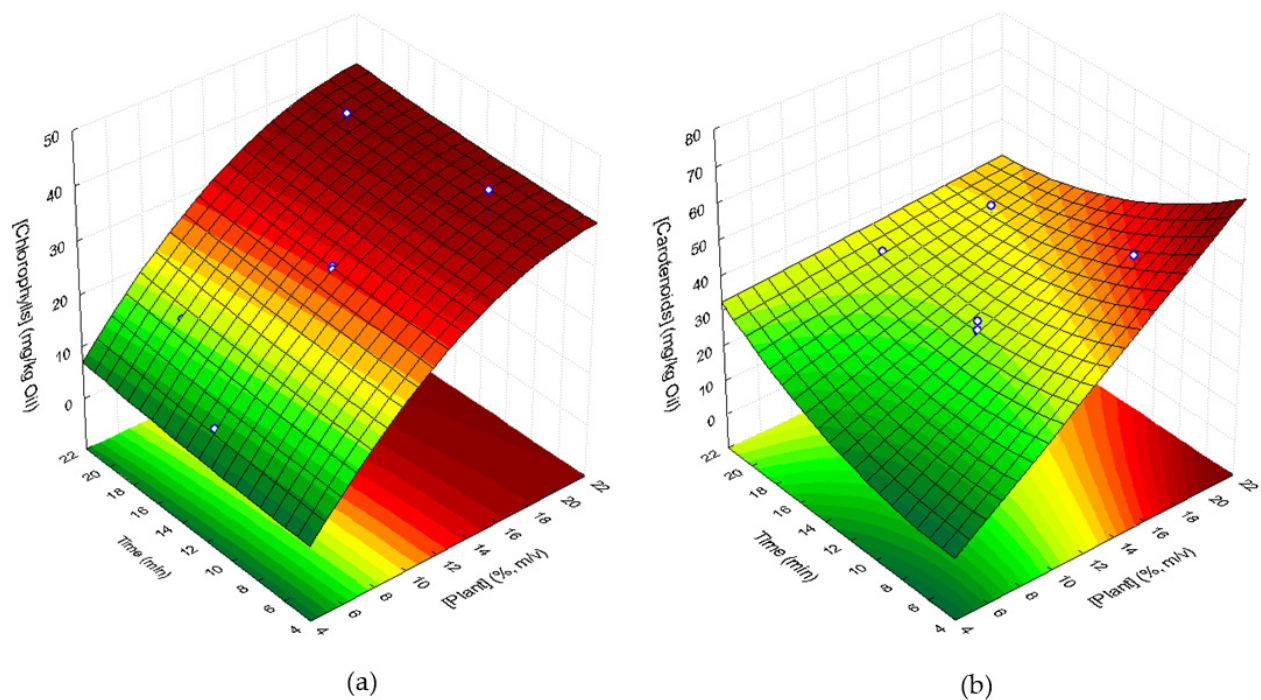
Figure 3. Response surfaces describing the contents of green pigments (chlorophylls), expressed in mg pheophytin a/kg of oil ( a ), and carotenoids, expressed in mg β -carotene/kg ( b ) of supplemented sunflower oil with lyophilized C. maritimum extracts, as a function of lyophilized C. maritimum concentration and UAE time.